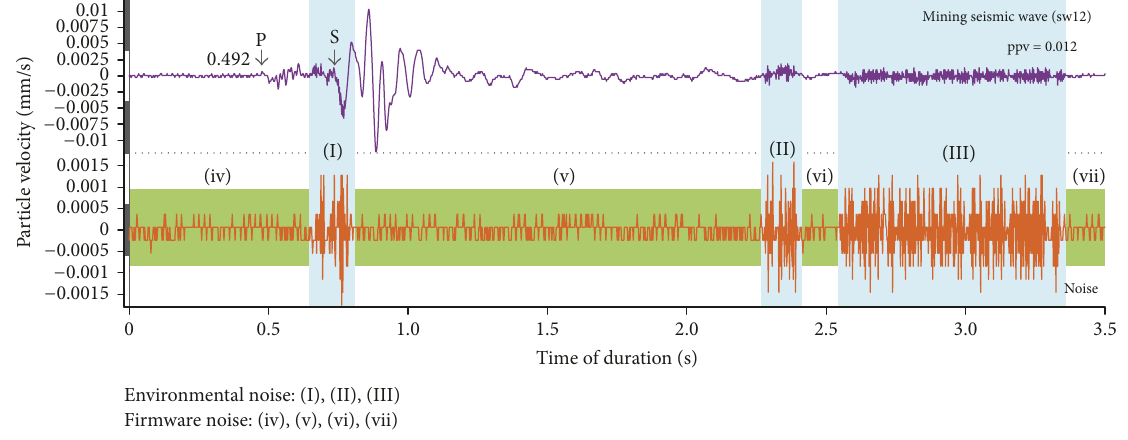
Figure 5: Waveforms of original microseismic wave sw12 and the reference